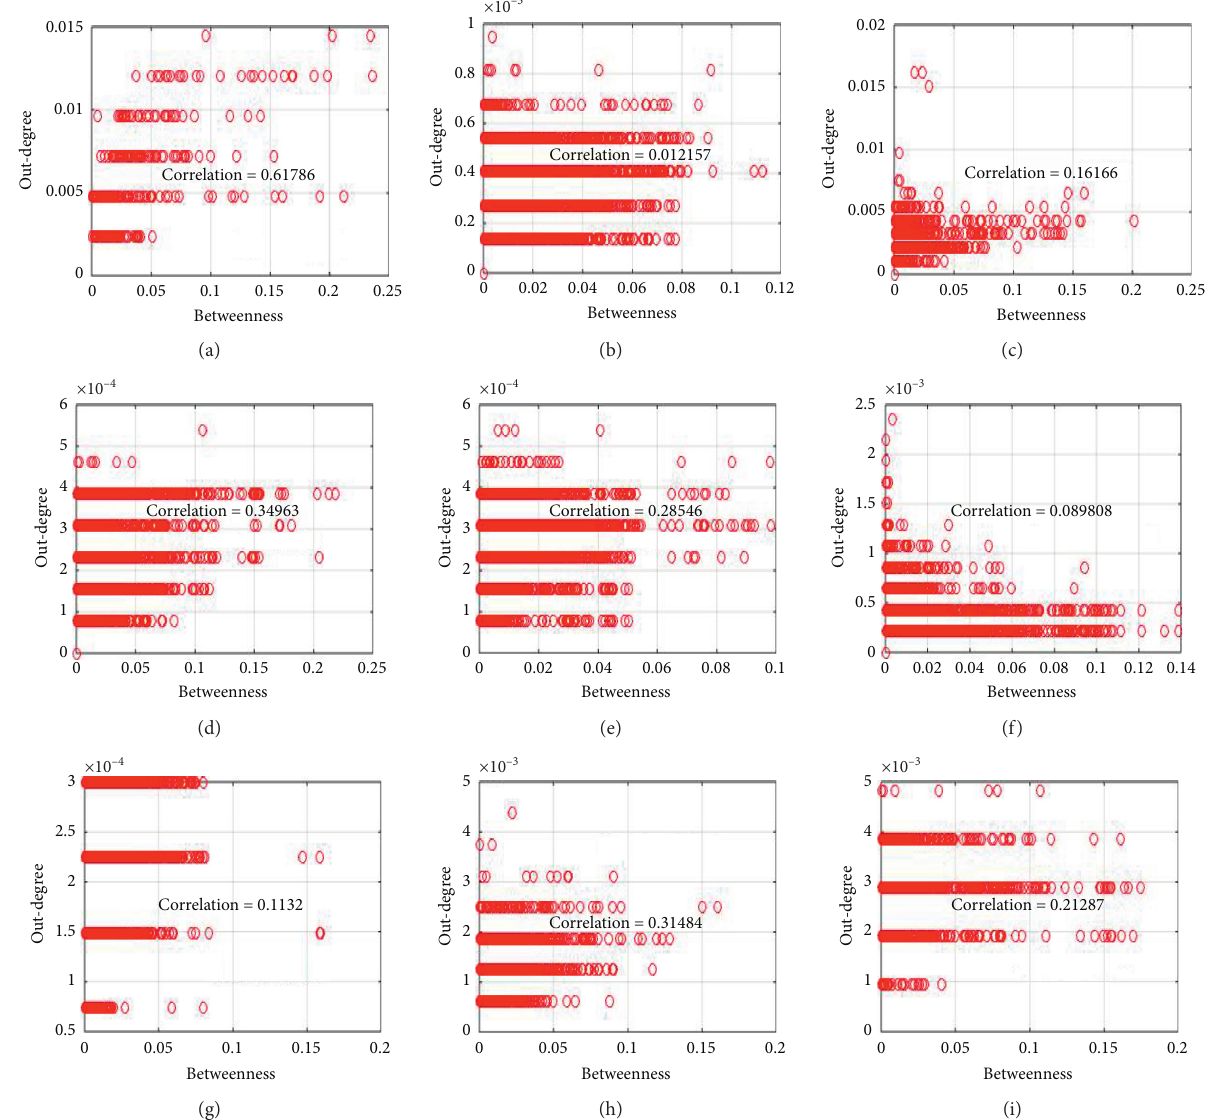
Figure 9: The correlation between normalized out-degree and betweenness: (a) Anaheim; (b) Austin; (c) Barcelona; (d) Berlin; (e) Chicago; (f) Hessen; (g) Philadelphia; (h) Terrassa; (i)